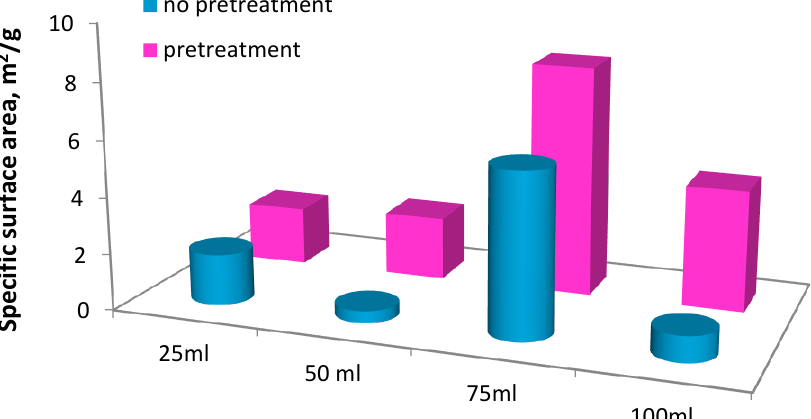
Figure 6. Influence of water quantity and heated stirring on the specific surface area of the produced materials.